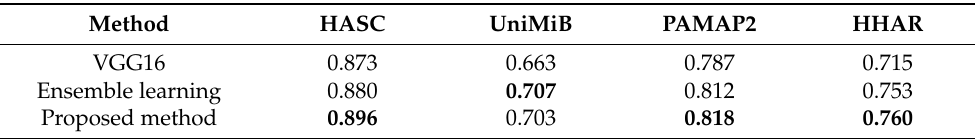
Figure 5. Important frequency of each activity in PAMAP2. The blue line in the graph shows the recognition accuracy when we masked the frequencies of the original sensor data in order. The red line shows the recognition accuracy when we used the original data. The yellow point is the lowest